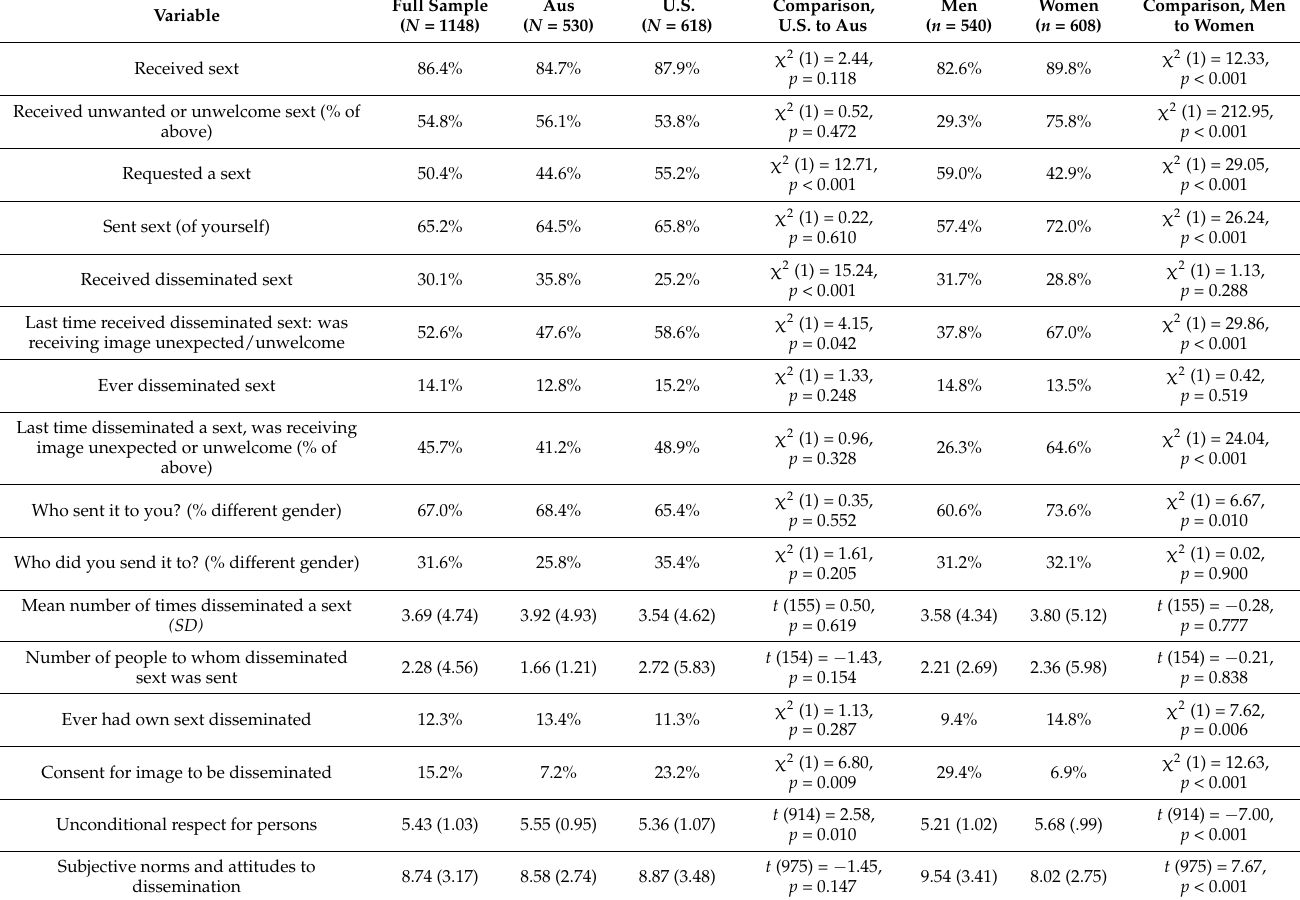
Table 1. Sexting behaviours for full sample, and by country and gender